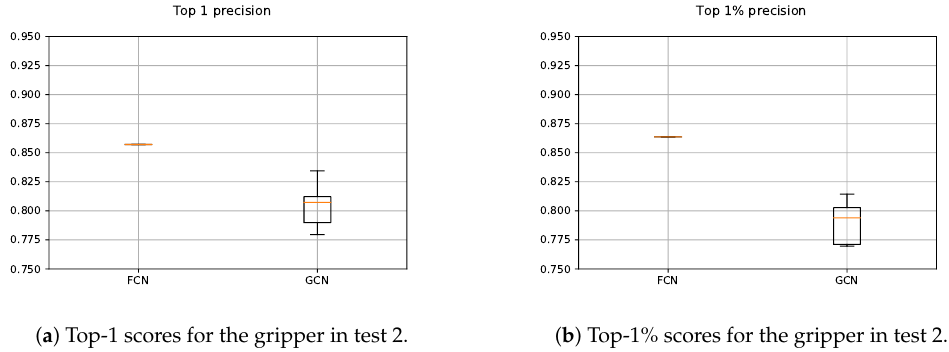
Figure 17. Suction result example with totally new objects. Top-left: point cloud of the scene. Top- right: ground-truth annotation. Bottom-left: top-1% predictions. Bottom-right: top-5% predictions.